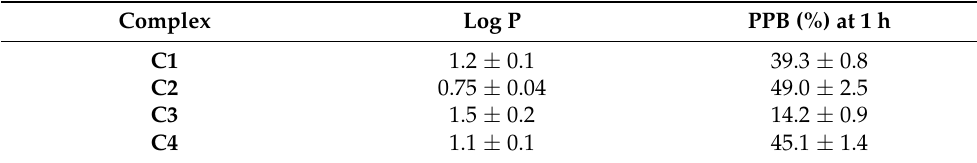
Table 3. Lipophilicity and plasma protein binding (PPB%) at 1 h incubation of 99m Tc complexes. Values are expressed as means ± SD, n =